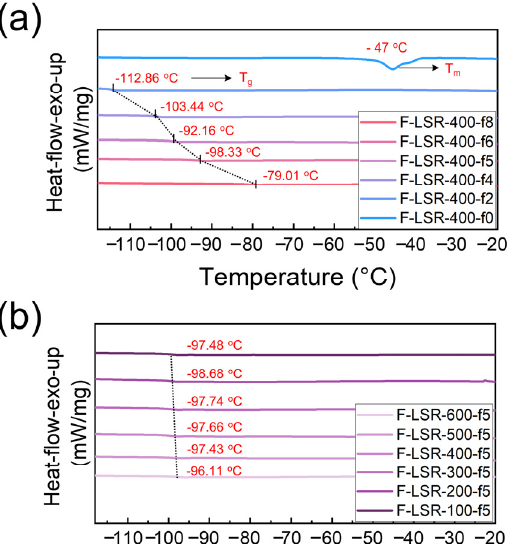
Figure 9. DSC curves of F-LSRs: ( a ) with different fluorine ratio and ( b ) with different chain-length.